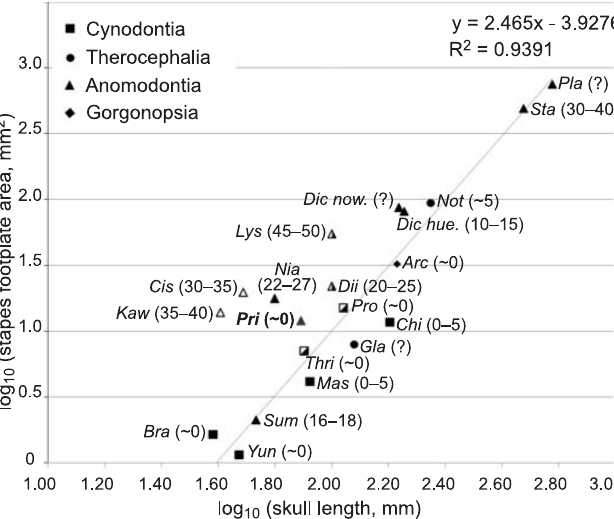
Fig. 8. Relative size of the stapes footplate area of the non-mammalian synapsid Pristerodon mackayi (MB.R.985) from the Late Permian of Biesjespoort, South Africa compared with those of other non-mammalian synapsids. The slope of the stapes for each taxon is added in brackets. The regression line is calculated only for non-fossorial species. Note that the sta- pes footplate area of Pristerodon is smaller than in fossorial taxa. Used data and material see SOM 1: table S2. Abbreviations: hollow symbols, fossorial species; partially filled symbols, semifossorial; filled symbols, non-fosso- rial or uncertain species; Arc, Arctognathus nasuta ; Bra, Brasilitherium riograndensis ; Chi, Chiniquodon theotenicus ; Cis, Cistecephalus plani- ceps ; Dic hue, Dicynodon huenei ; Dic now, Dicynodontoides nowacki ; Dii, Diictodon feliceps ; Gla, Glanosuchus sp.; Lys, Lystrosaurus declivis ; Mas, Massetognathus pascuali ; Nia, Niassodon mfumukasi ; Not, Nothosollasia lückhoffi ; Pri, Pristerodon sp.; Pla, Placerias gigas ; Pro, Procynosuchus delaharpeae ; Sta, Stahleckeria potens ; Sum, Suminia getmanovi ; Thri, Thrinaxodon liorhinus ; Yun, Yunnanodon . Modified from Laaß